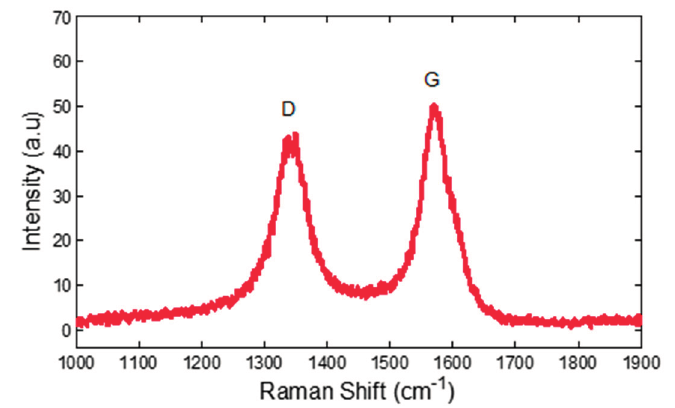
Figure 5. Raman shift of the CNT nanostructured thin films.